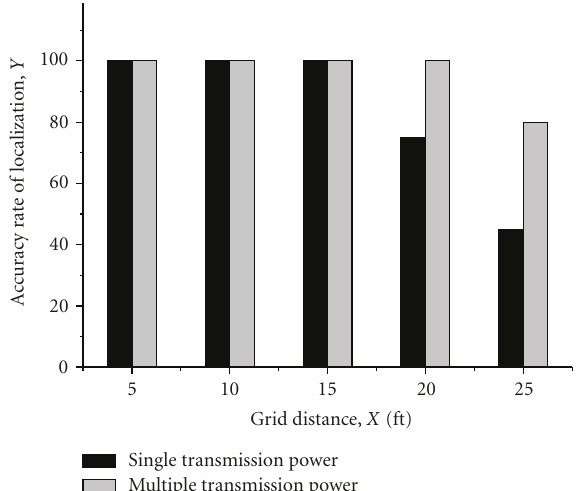
Figure 16: Localization accuracy comparison by using di ff erent transmission